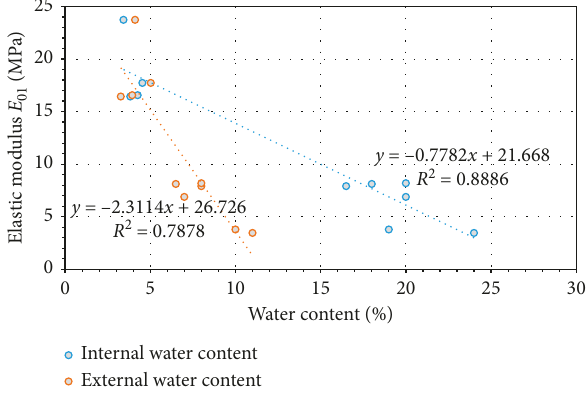
Figure 12: Dependence of elastic modulus on internal and external water